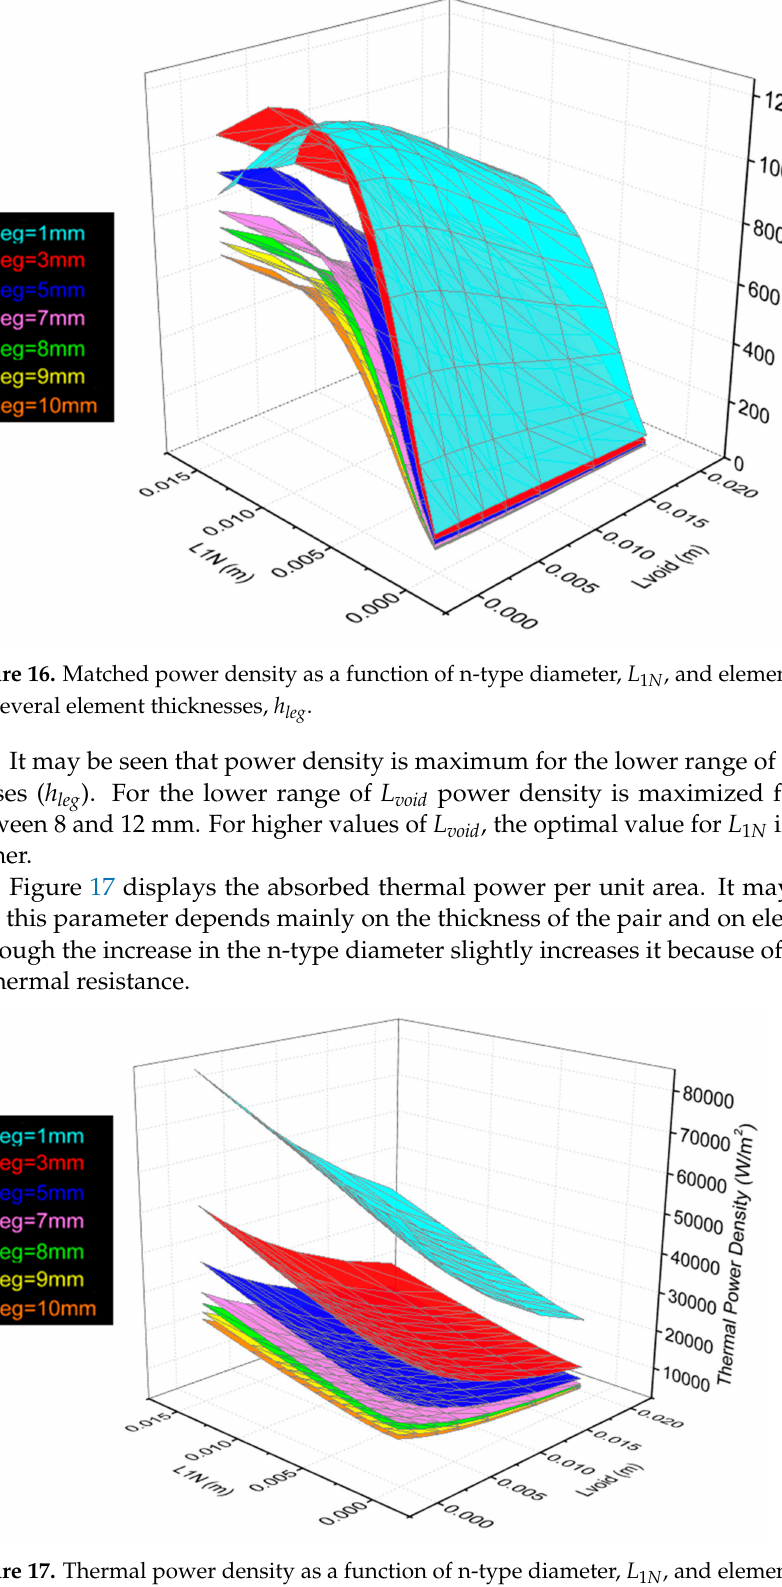
Figure 17. Thermal power density as a function of n-type diameter, L 1 N , and element spacing, L void , for several element thicknesses, h leg